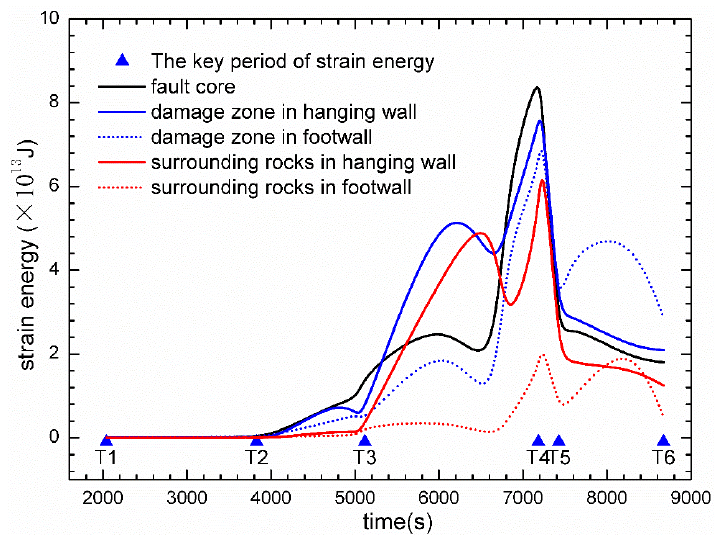
Figure 20. The distribution of strain energy at different locations in the normal fault over time.